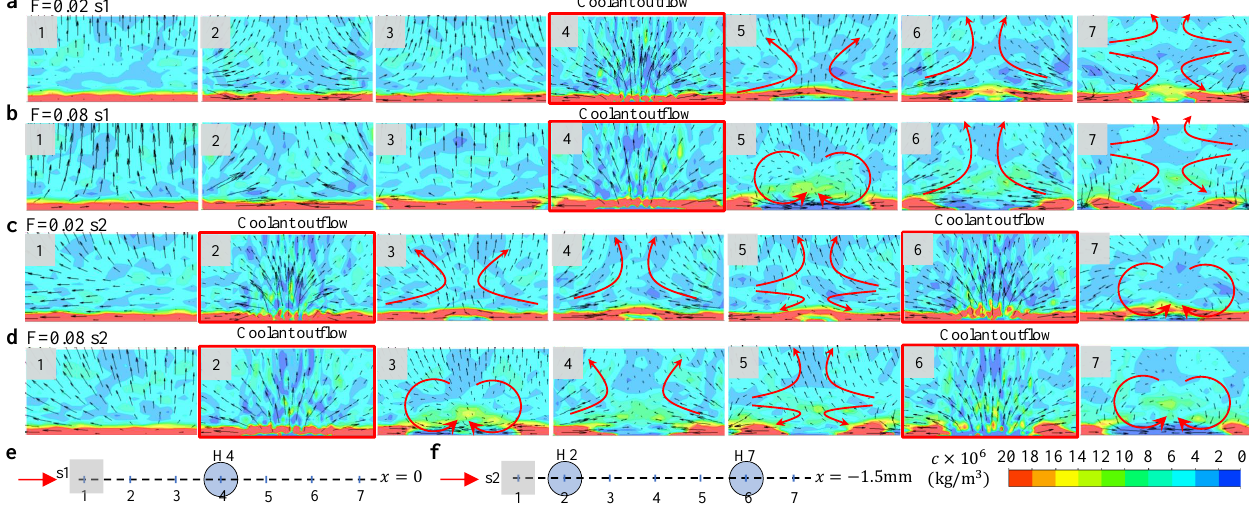
Figure 8. The contours of the particle mass concentration c with accompanied velocity vector field at different x − z cross sections along s1 or s2 at different blowing ratios: ( a ) F = 0.02-s1, ( b ) F = 0.08-s1, ( c ) F = 0.02-s2, and ( d ) F = 0.08-s2. The cross sections where cooling outflow happens are highlighted. The schematics of the positions of the cross section along ( e ) s1 and ( f )